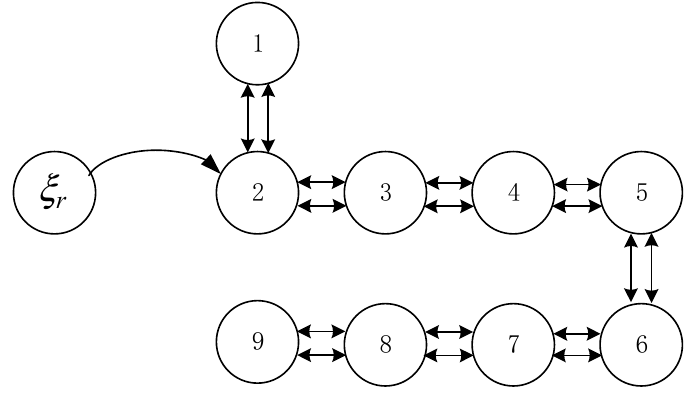
Figure 7. Information-exchange topologies.